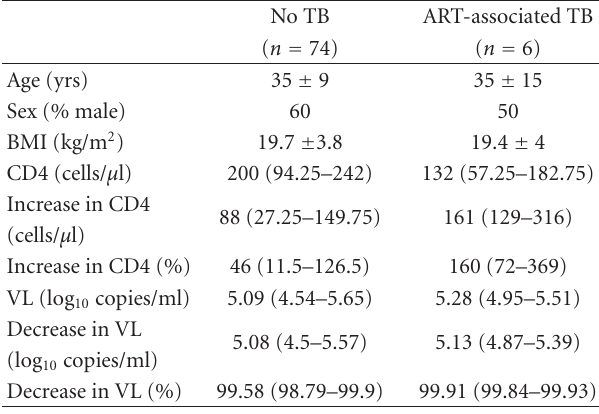
Table 6: Comparison of characteristics between patients with and without ART-associated TB in 80 patients with